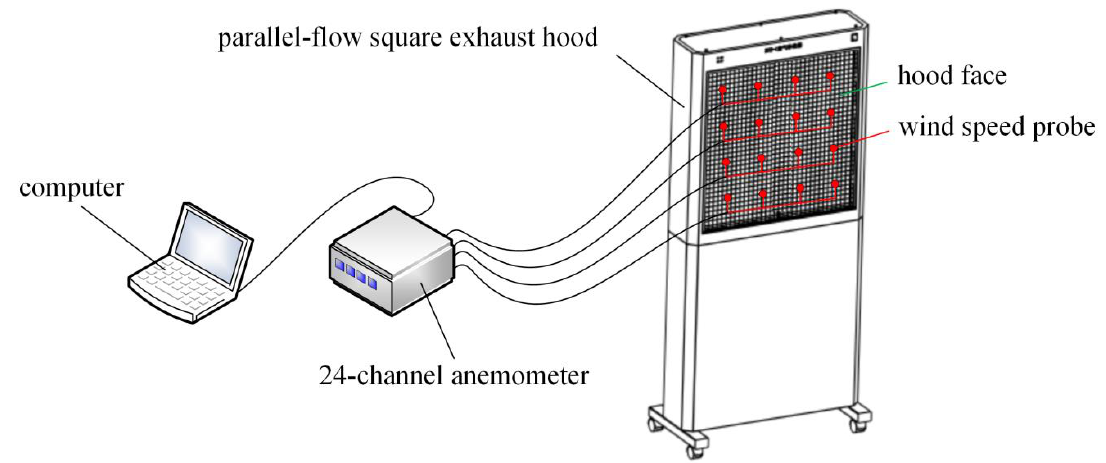
Figure 6. Schematic diagram of velocity detection at the hood face of experimental setup.